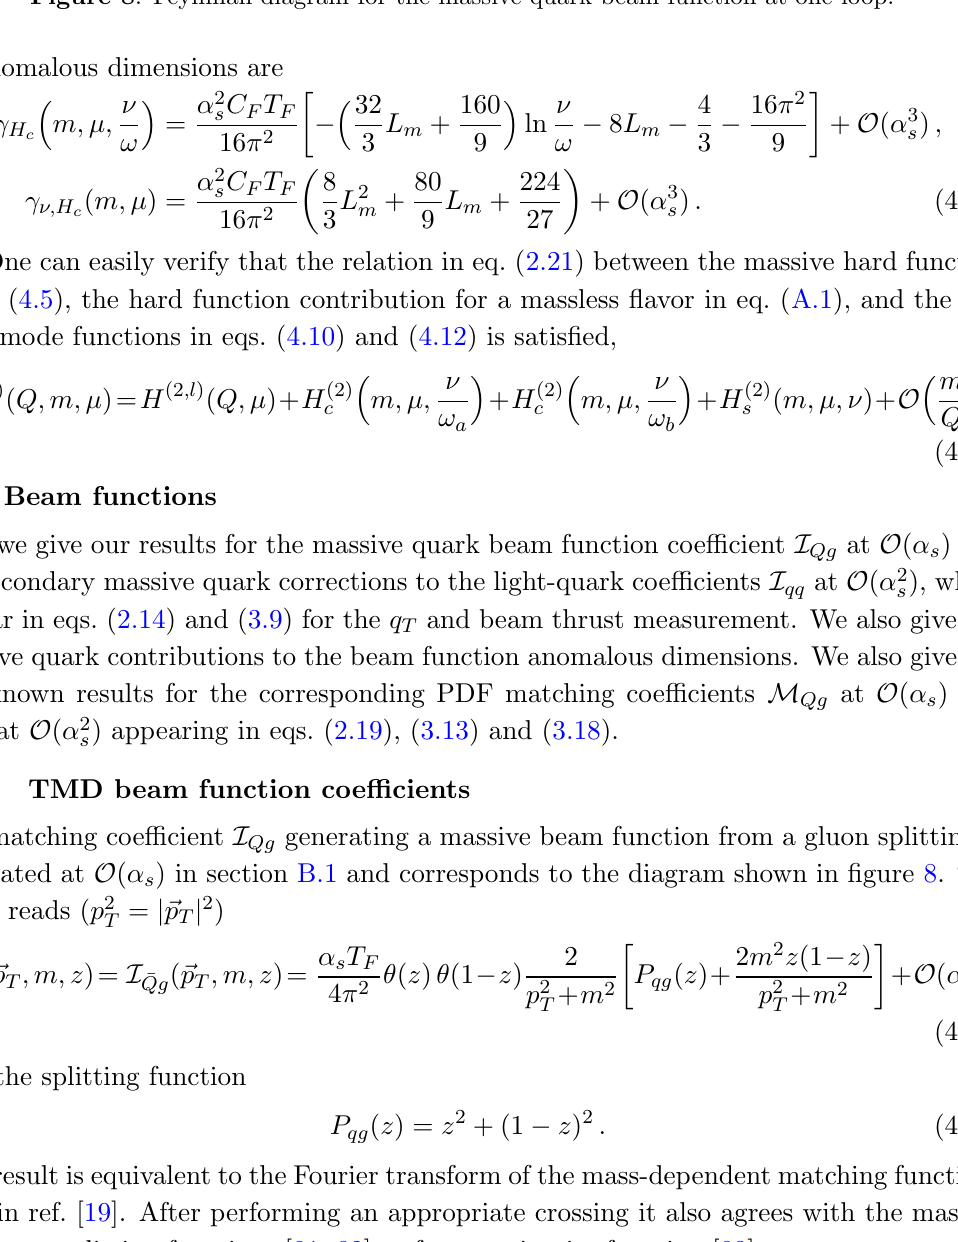
Figure 8 . Feynman diagram for the massive quark beam function at one